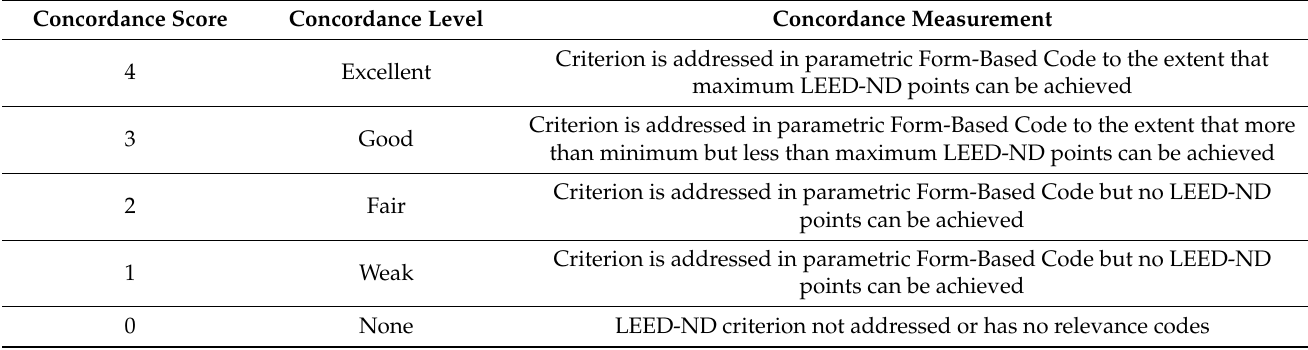
Table 1 describes the concordance levels and measurement descriptions. Table 1. Concordance levels and measurement descriptions